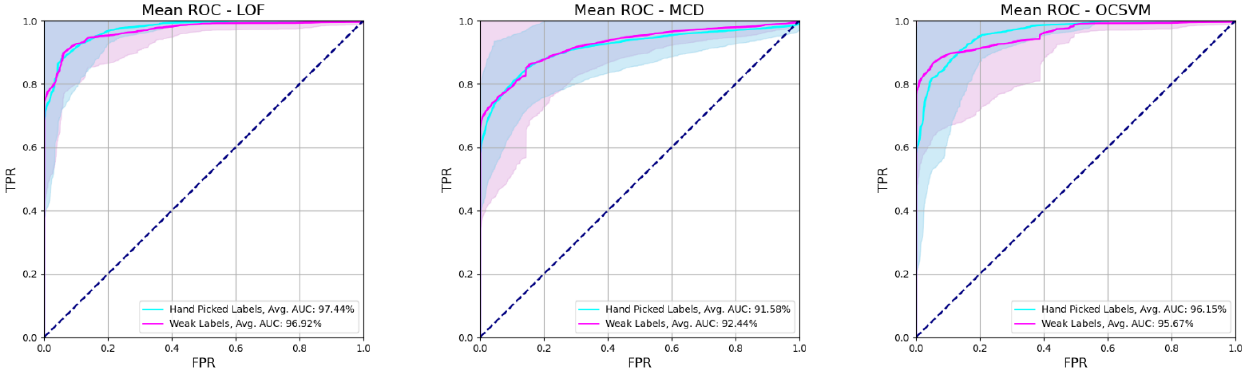
Figure 3. Average ROC curves and AUC for the three models across all experimental cases. Shaded areas reflect the standard deviation of the curves.